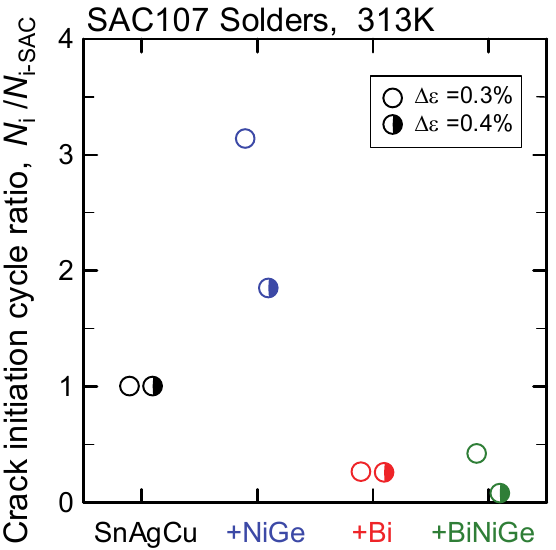
Figure 5: Effect of additive elements on crack initiation